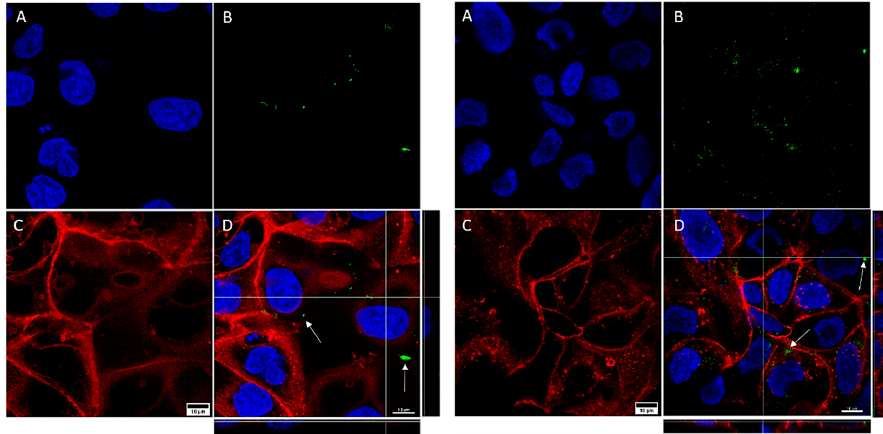
Figure 5. Confocal microscopy captures of Caco2 cells. The images show cells treated with NF-GNPs (left) and cells treated with anti-EpCam-functionalized GNPs (right). Nuclei ( A ) are marked blue (Hoechst 33342), plasma membranes ( C ) are marked red (CellMask™ Deep Red). Nanoparticles ( B ) are visualized as green dots due to their reflection being artificially assigned a green color by the microscope’s software. Merged images ( D ), and their orthogonal projections of the z-stack recon- structions (right and bottom), where GNPs (white arrows) can be seen.